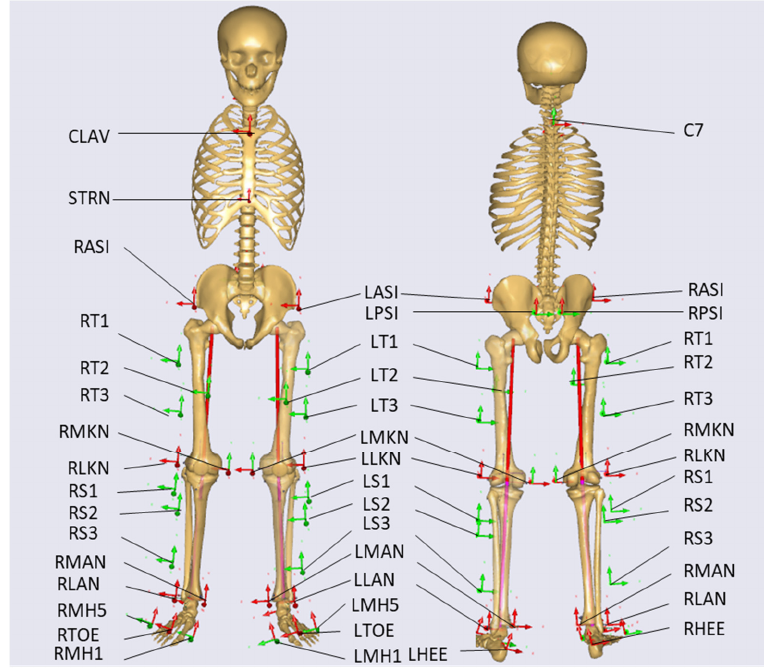
Figure 1. Locations and names of the reflective markers.